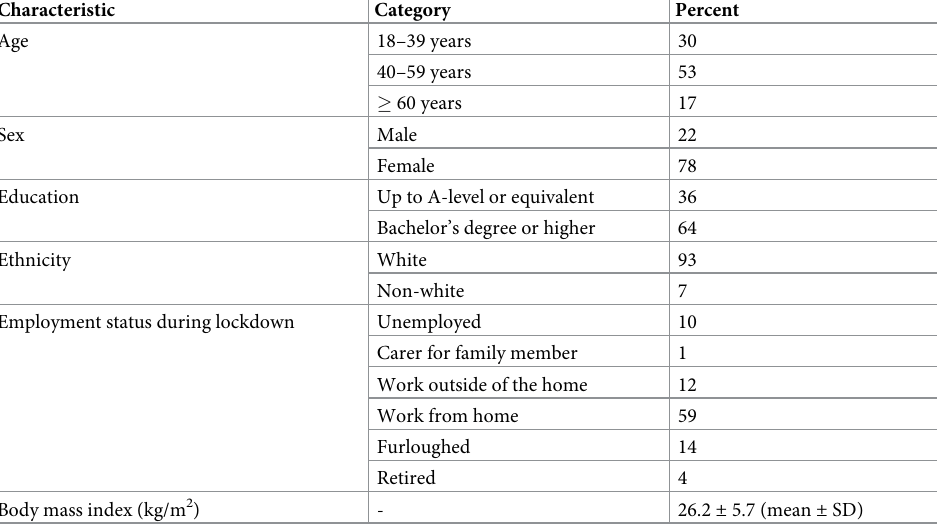
Table 1. Participant characteristics (n =